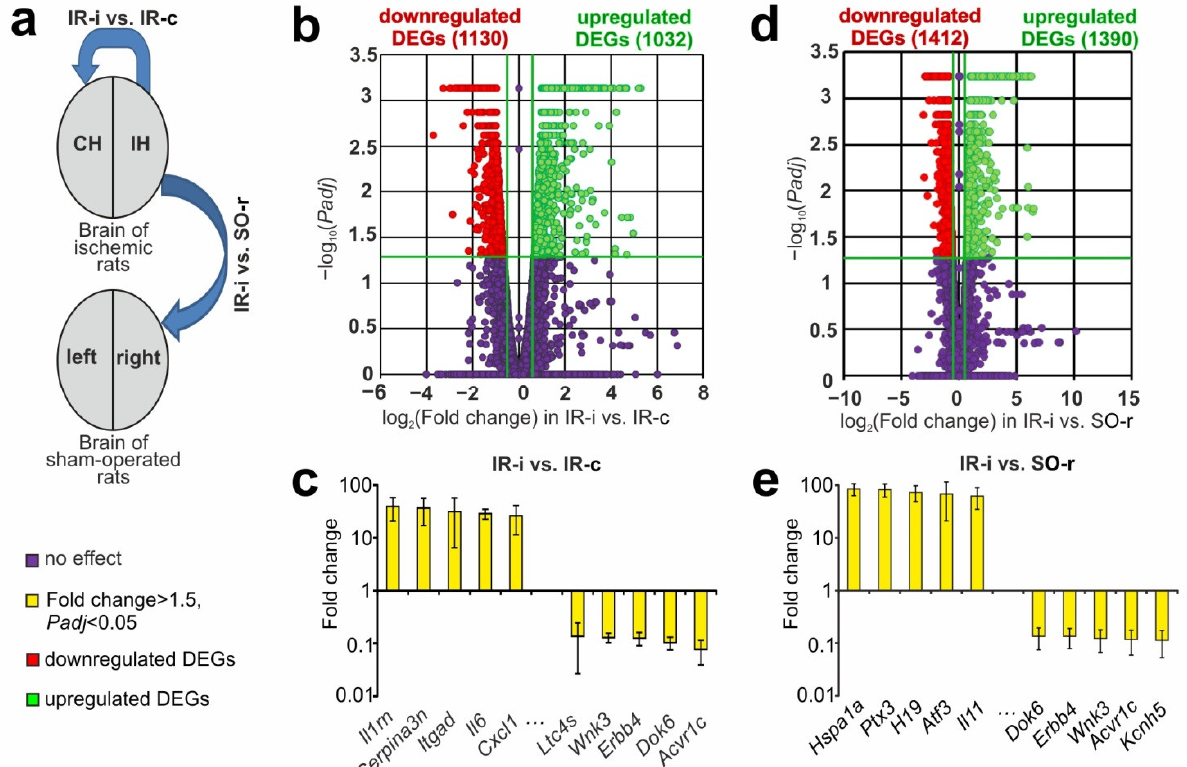
Figure 2. Genome-wide transcriptome changes recorded at 24 h after tMCAO in subcortical structures of the IH related to the sham-operated (SO) and contralateral controls. ( a ) The data comparison scheme is presented. The blue arrows indicate comparisons of IH samples from ischemic (IR) rats vs. right hemisphere samples of SO rats, as well as between IH and CH samples of IR animals. ( b , d ) The RNA-Seq results presented are for IR-i vs. IR-c ( b ) and IR-i vs. SO-r ( d ) using volcano plots. The cutoff for gene expression changes was a 1.50-fold change. Only those genes with p -values adjusted using the Benjamini–Hochberg procedure ( Padj < 0.05) were selected for analysis. Up- and downregulated DEGs are represented as green and red dots, respectively. Genes that were not differentially expressed are presented as dark purple dots (fold change ≤ 1.50; Padj ≥ 0.05). ( c , e ) Top 10 genes that exhibited the greatest fold change in expression in IR-i vs. IR-c ( c ) and IR-i vs. SO-r ( e ). The data are presented as the mean ± standard error (SE) of the mean. Three animals were included in each comparison